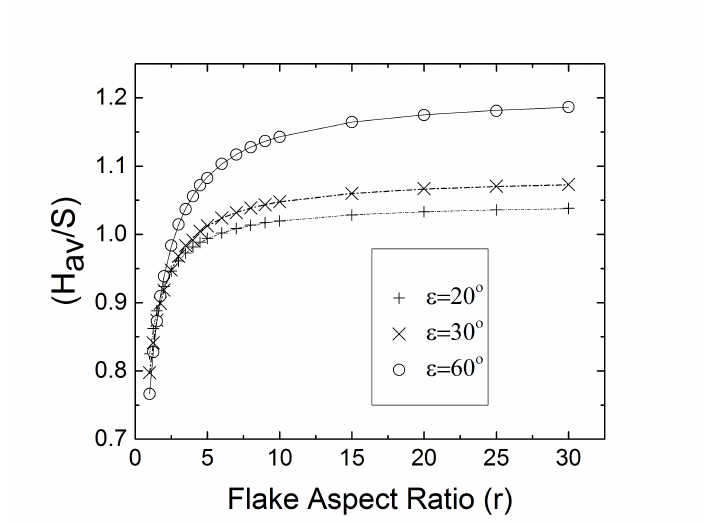
Figure 7. Comparison between the average intersection length H av / S predicted from Equation (10) (lines) and values computed from numerical sectioning experiments (points) for various values of (cid:101) and r .